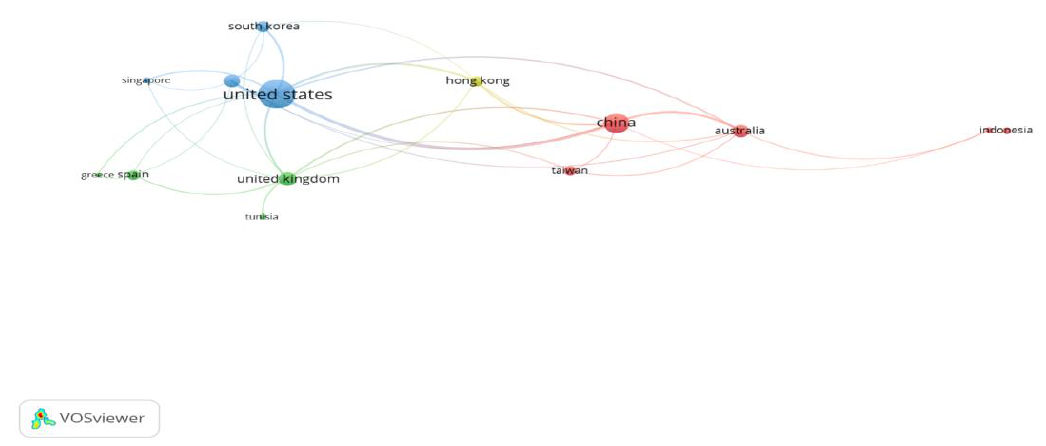
Figure 3. Co-authorship among countries.